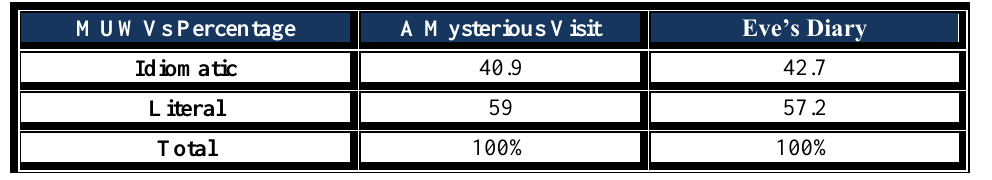
Table 8 – Comparison of MUWVs percentages in MV and